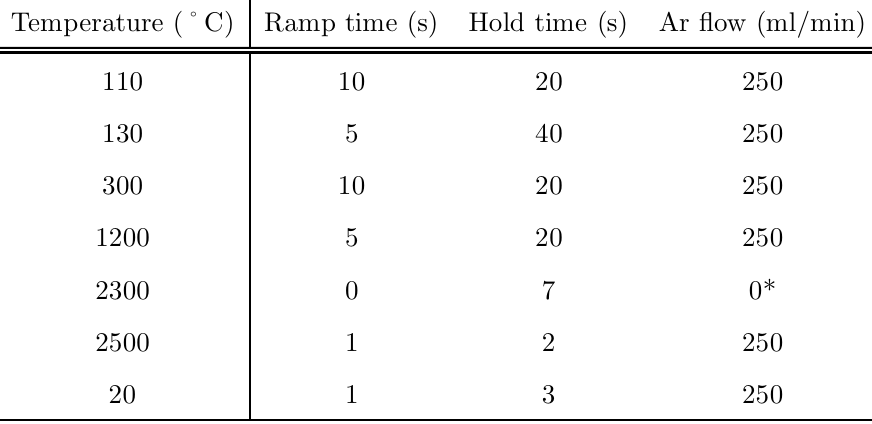
Table 2 Analytical conditions for As and graphite furnace